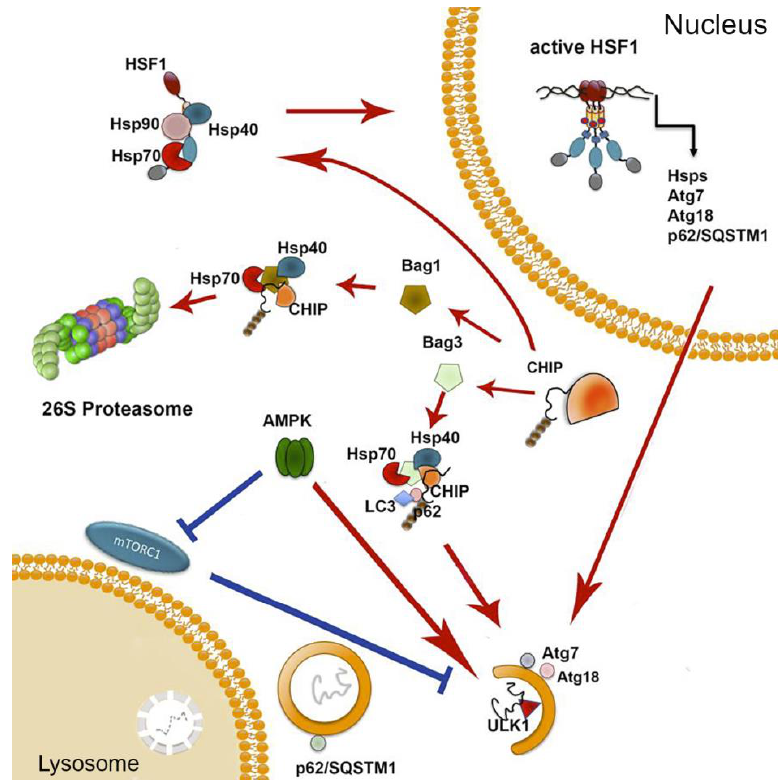
Figure 3. Functional links between proteostasis machineries. The major modulator of heat shock response HSF1, besides its classic downstream targets (Hsps), regulates the expression of proteins related to autophagy function: p62, substrate, and indicators of autophagosomes, as well as Atg7 and Atg18 participating in autophagosome assembly; all three proteins are implicated in the aging process. HSF1 was also shown to protect mTORC1 from JNK-mediated inactivation. AMPK was implicated in the regulation of both mechanisms: the activation of autophagy through phosphorylation of ULK1 and mTORC1, as well as inhibition of HSF1, also by the factor’s specific phosphorylation. The CHIP/Bag-1/Hsp70 complex is able to target a protein substrate to proteasomal degradation; cooperation of CHIP with Bag-3, LC-3, and p62 leads to a substrate targeting to autophagy. mTORC1 and AMPK can phosphorylate ULK1, but with distinct results. Depending on caloric supply, mTORC1 may phosphorylate ULK1 at Ser 757 , and via this inhibit autophagy; alternatively, in the absence of energy, AMPK phosphorylates ULK1 at Ser 555 , leading to the stimulation of autophagy.